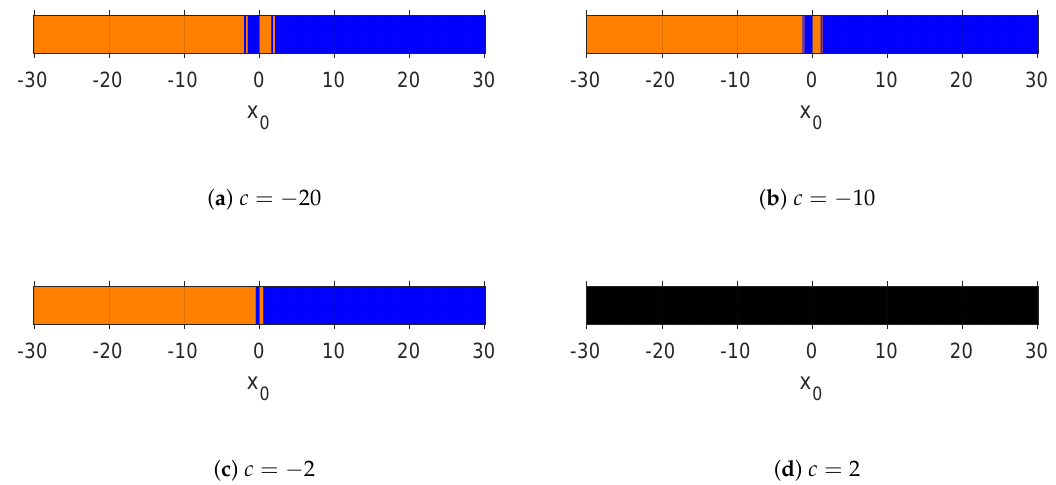
Figure 2. Dynamical lines of Traub’s method on p c ( x ) = x 2 + c for different values of c . Color basins: ( c ) orange, x F ( c ) blue, no convergent points in x F 2 1